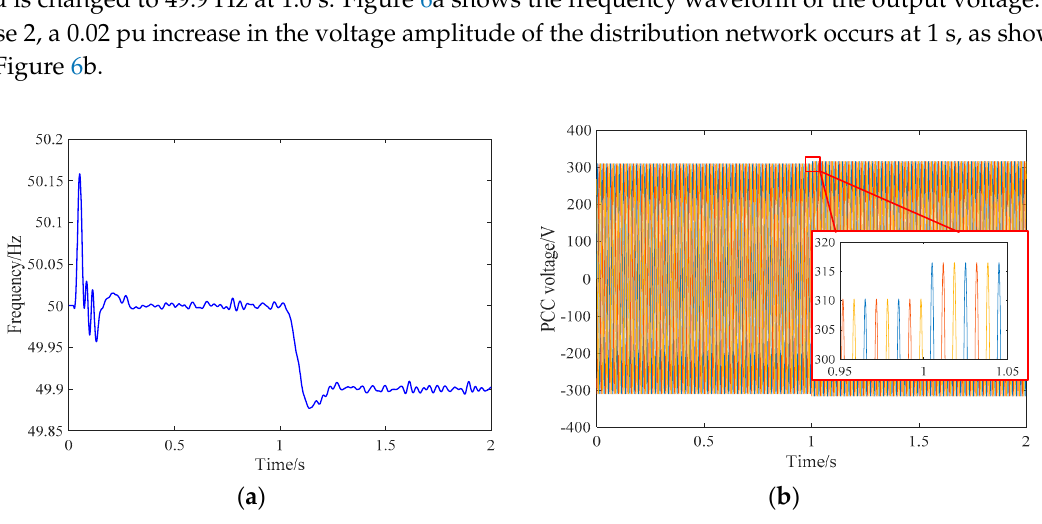
Figure 6. ( a ) The frequency waveform of the output voltage; ( b ) The PCC voltage